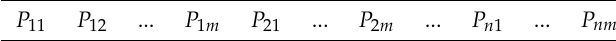
Table 2. Power allocation chromosome.